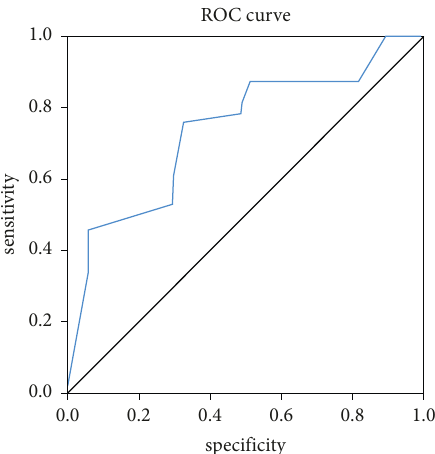
Figure 1: ROC curve for validating the predictive